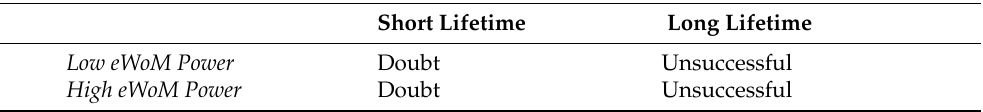
Table 15. Categorization of the posts associated with the lifespan template “Gray”.